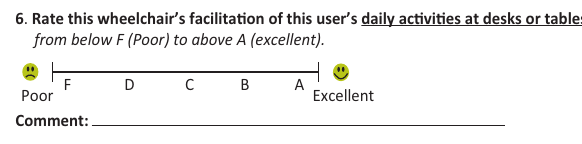
FIGURE 1: An example of a question on the Wheelchair Interface